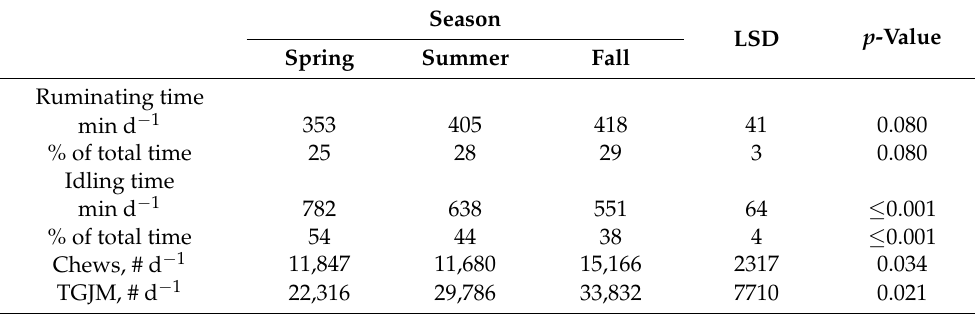
Table 3. Effect of season on ruminating time, idling time, number of chews, and total grazing jaw movements (TGJM) of grazing dairy heifers. Means are average of two